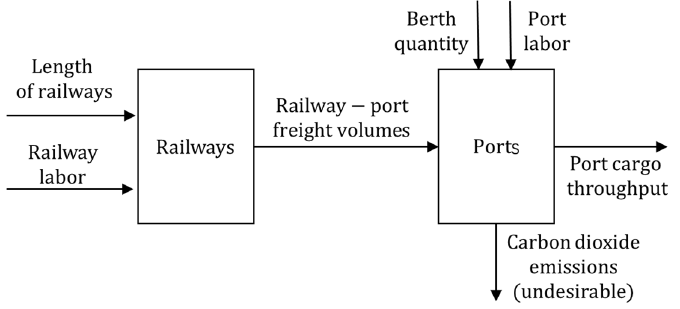
Figure 4. Two-stage network structure of rail-water intermodal transport. Table 1. References for variable selection